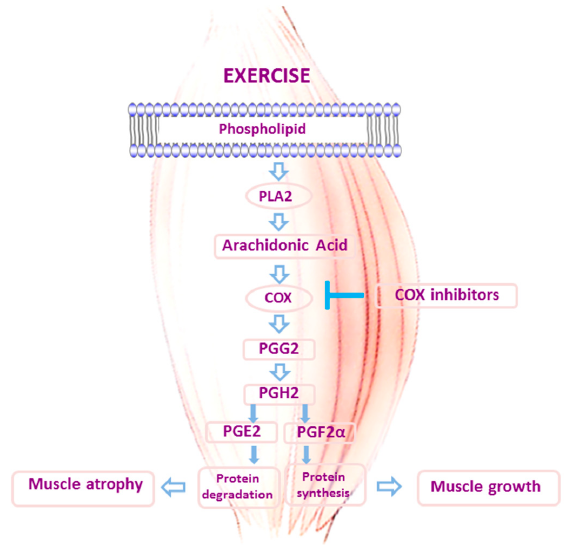
Figure 2. Schematic representation of the regulation of skeletal muscle protein metabolism through the COX pathway.